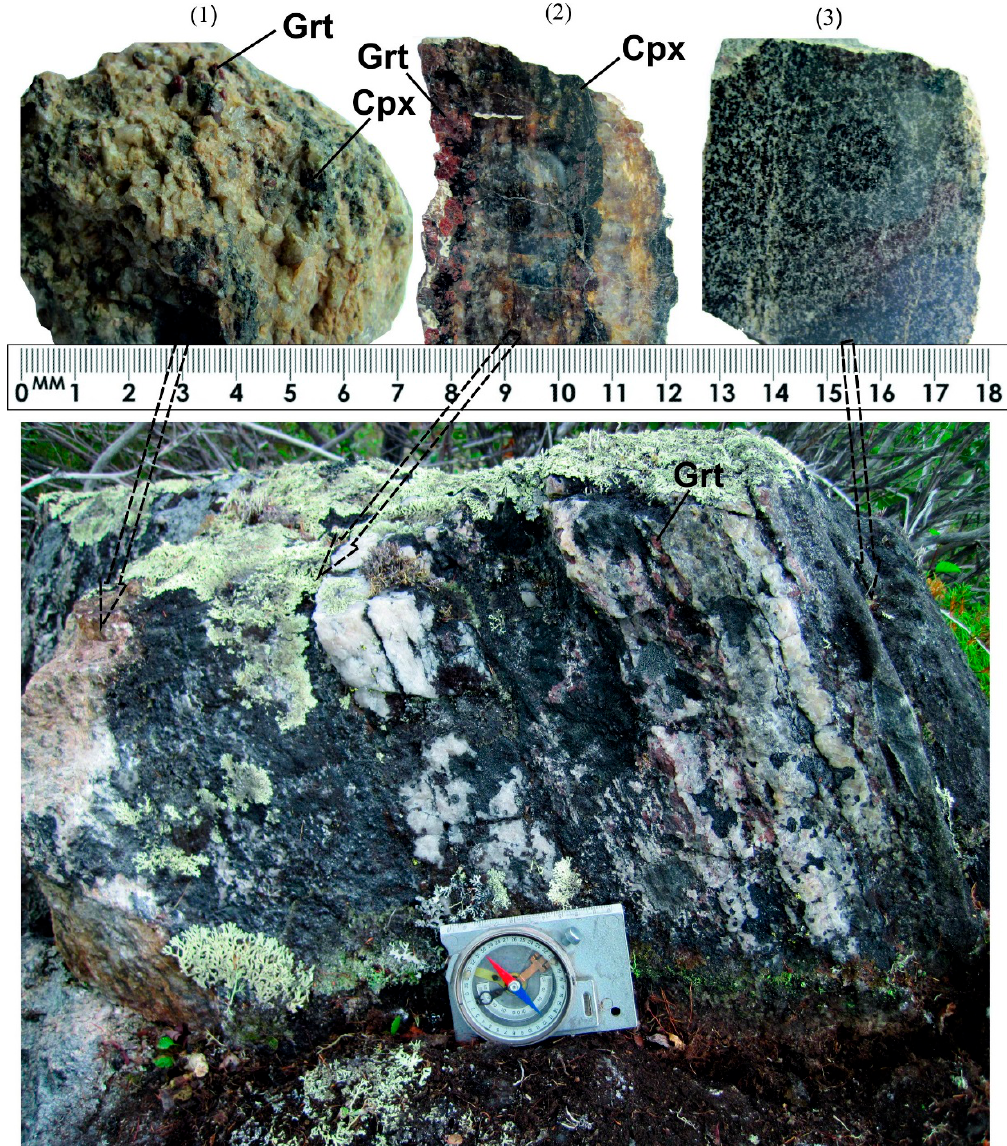
Figure 4. Outcrop 823. 1—coarse-grained Grt-Cpx gneisses (sample 823); 2—the contact of Grt-Cpx gneisses with quartzites; 3—Cpx-Opx schists (sample 823-2). Coordinates: 69°43'20''N, 110°29'33''E.